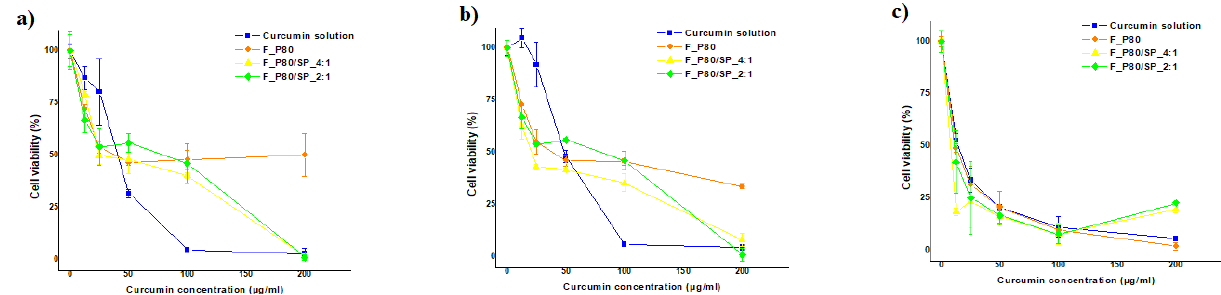
Figure 8: Cell viability assay: a) MRC-5 cell line; b) Fem-X cell line; c) HeLa cell line. Cells were incubated with several concentrations of the investigated curcumin nanocrystal dispersions and curcumin solution. Obtained data show cell viability dependence on the curcumin concentration. Each experiment was repeated three times and the results were presented as the mean value ± SD